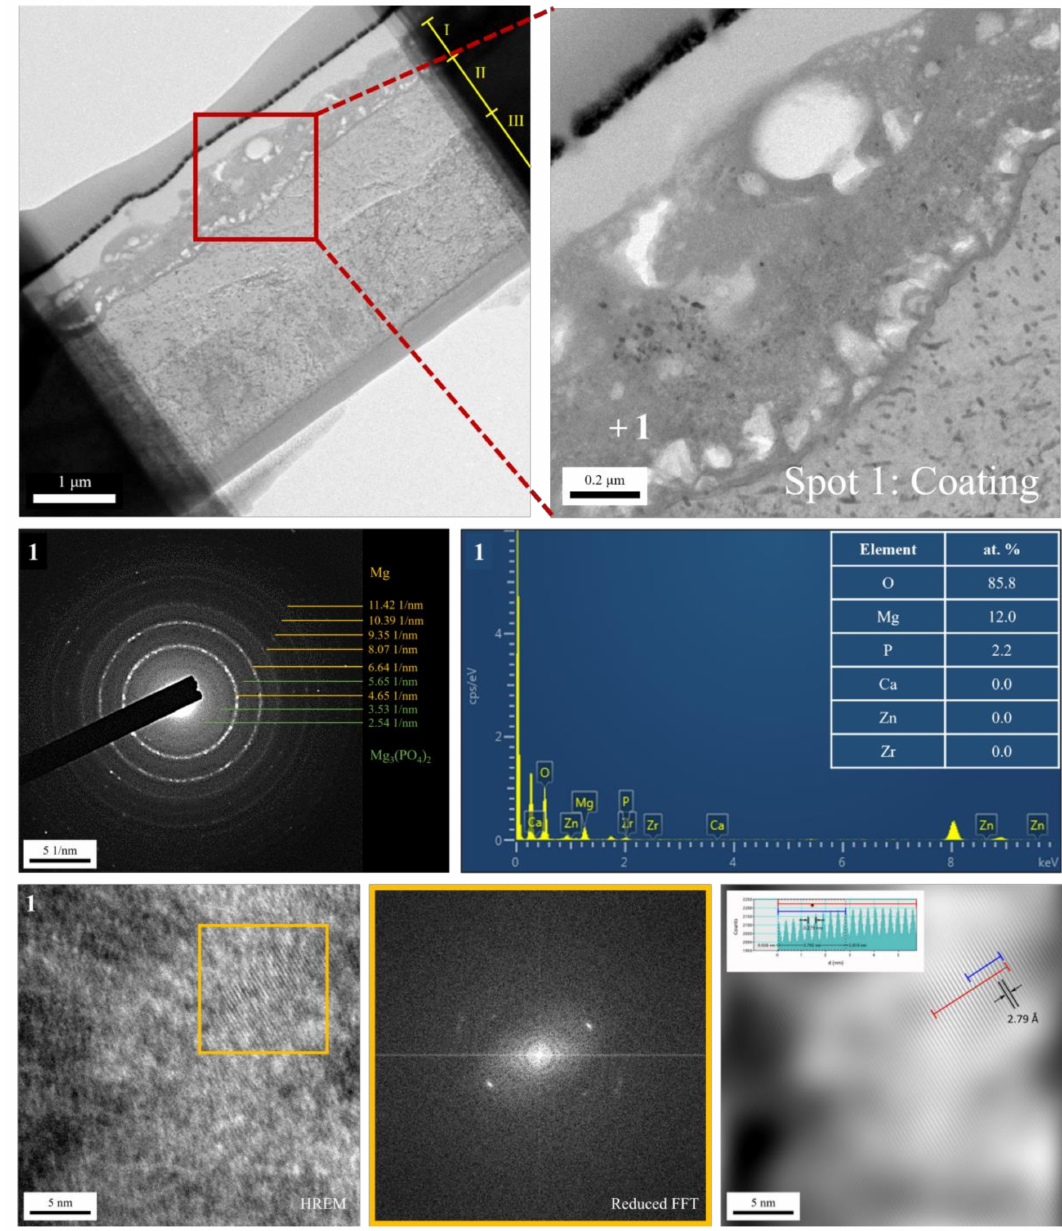
Figure 7. TEM analysis of the anodic